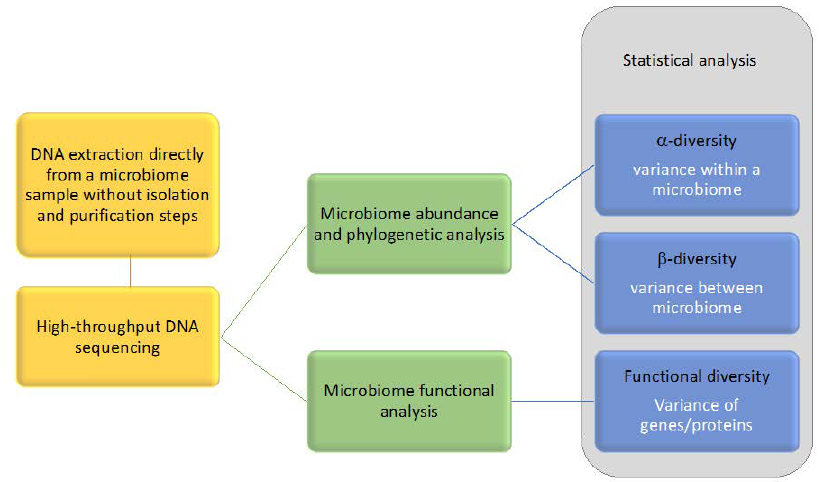
Figure 1. Main steps of metagenomic